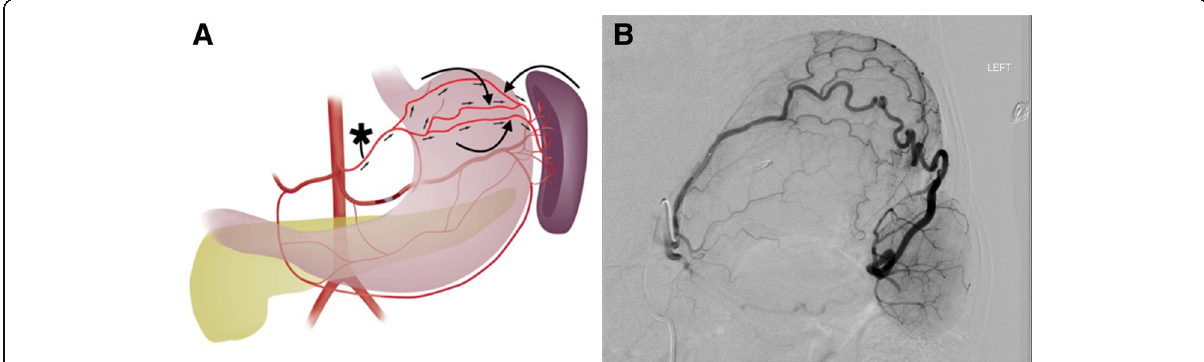
Fig. 10 a Schematic of collateral splenic perfusion via the left gastric (star) to short gastric pathway (curved arrows). Note that the normal direction of flow is reversed in the short gastric arteries. b 39 year old female with history of splenic laceration caused by motor vehicle accident 11years prior which was treated with a subtotal splenectomy as well as splenic artery and vein ligation. Left gastric artery angiogram done for bleeding gastric varices demonstrates the left gastric to short gastric to spleen collateral